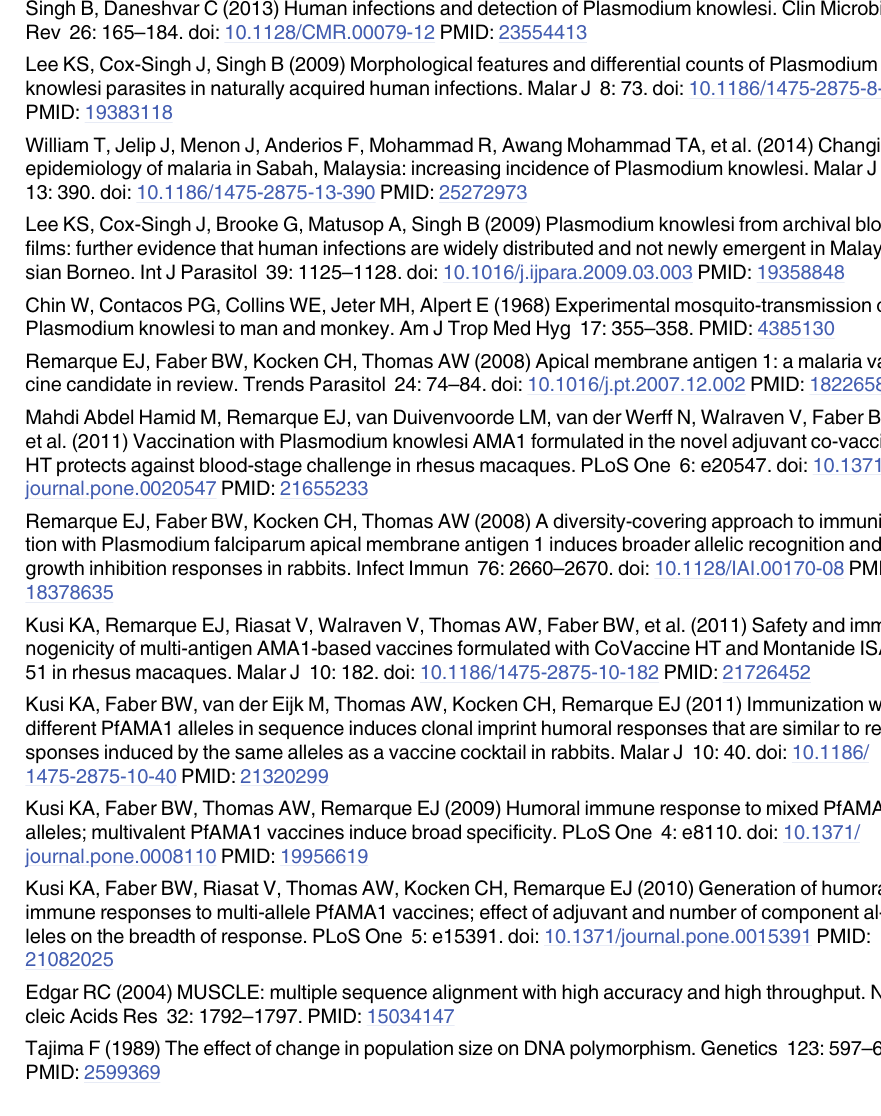
S1 Table. Haplotypes identified in each of the divisions. BTG = Betong, CDK = Kapit Divi-